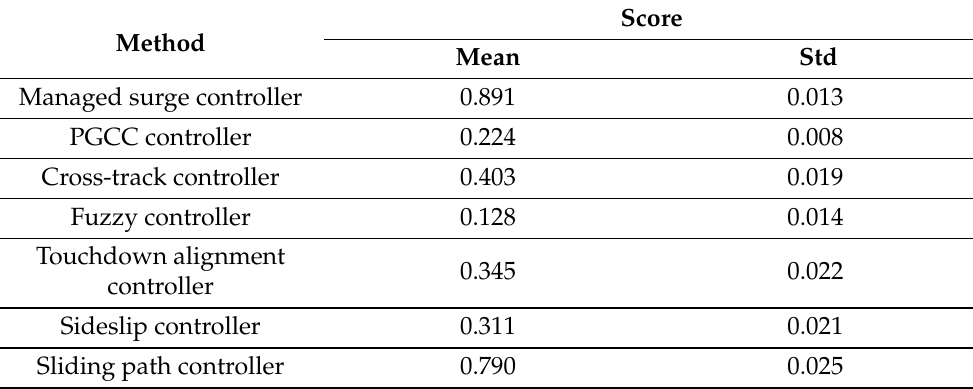
Table 1. Score results comparison between the different methods, taking the results of the level 3 of